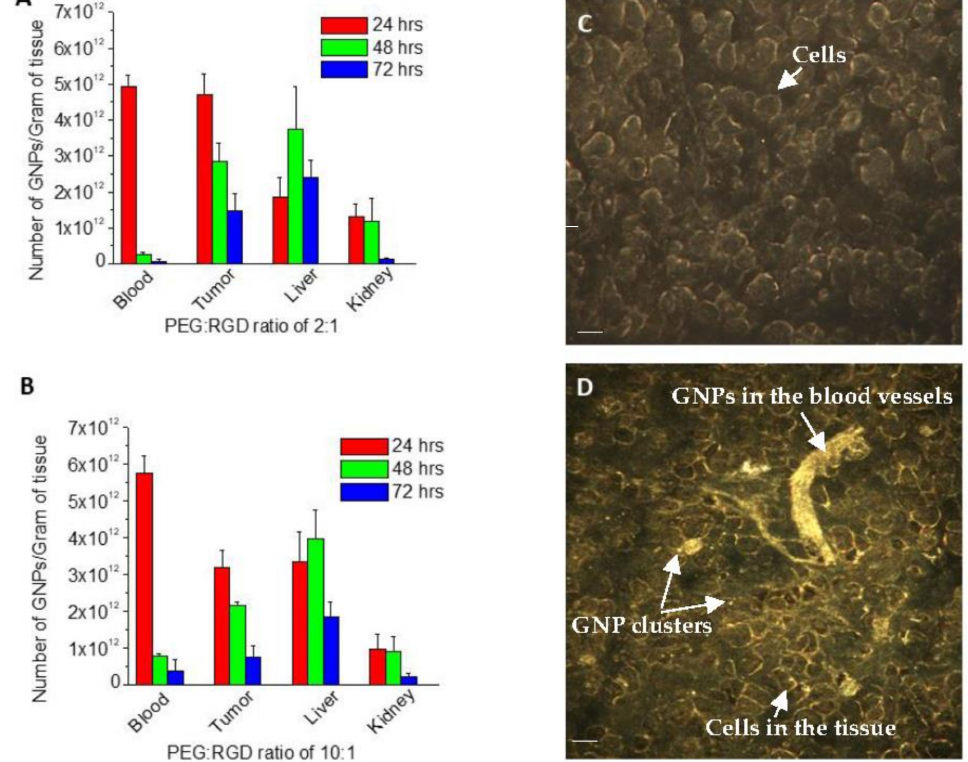
Figure 6. ( A )AccumulationofGNP-PEG-RGD(2:1)invariousorgansofseverecombinedimmunodeficiency (SCID) mice; ( B ) Accumulation of GNP-PEG-RGD (2:1) in various organs of SCID mice; ( C ) GNP accumulation in tumor immediately post-injection. Scale bar = 10 µ m; ( D ) GNP accumulation in tumor 24 h post injection. Scale bar = 10 µ